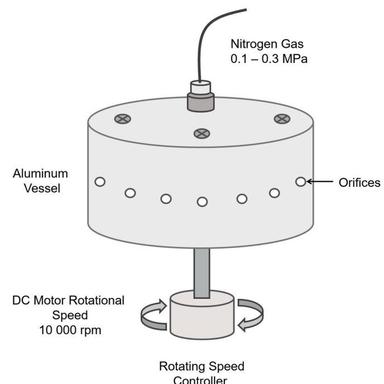
Schematic illustration of binary composite production using pressurized gyration.